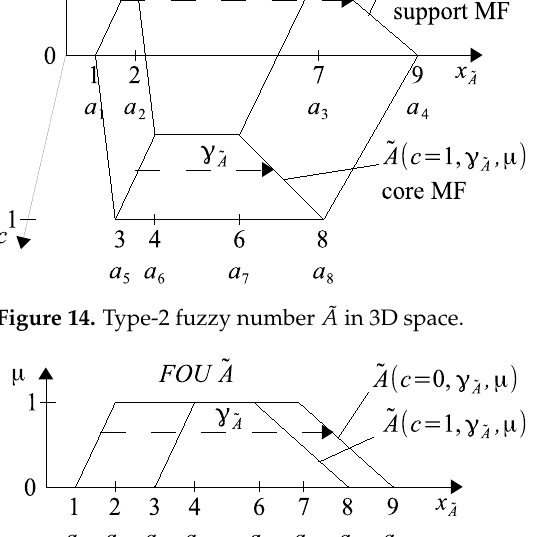
, x A ) from 3D space to the M × X A A